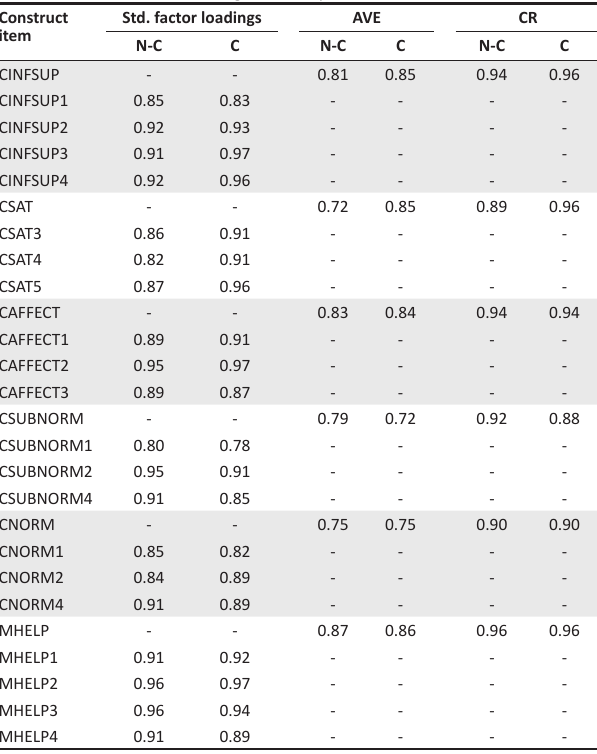
TABLE 2: Assessment of convergent